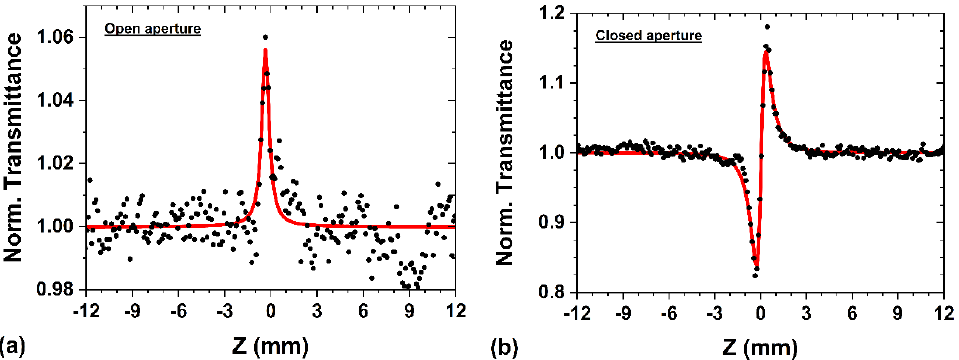
Figure 3. Normalized transmittance of z-scan measurements for ( a ) open aperture (OA) and ( b ) closed aperture (CA) for an Ir coating with 45 ALD cycles.